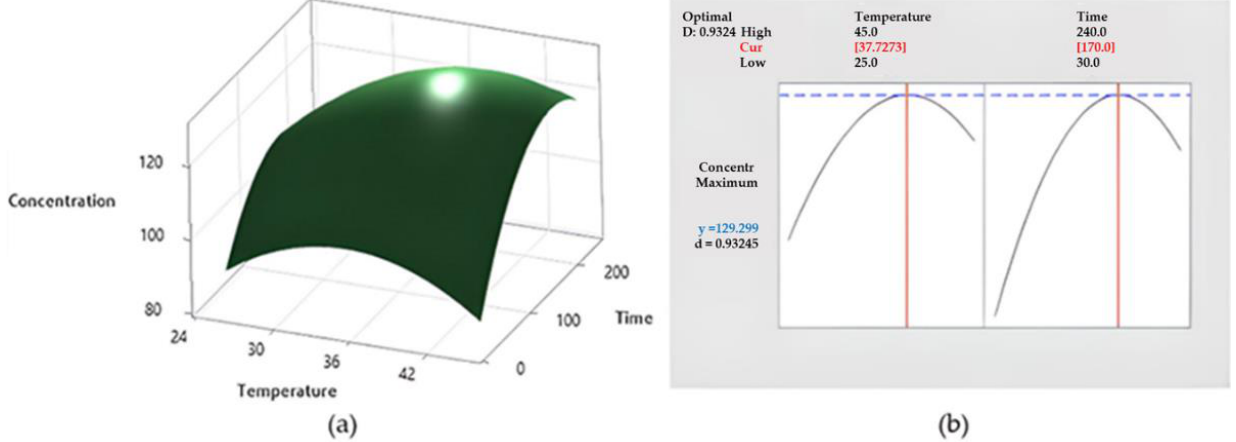
Figure 2. ( a ) Surface plot of phlorizin concentration cv time and temperature; and ( b ) multiple response prediction analysis.